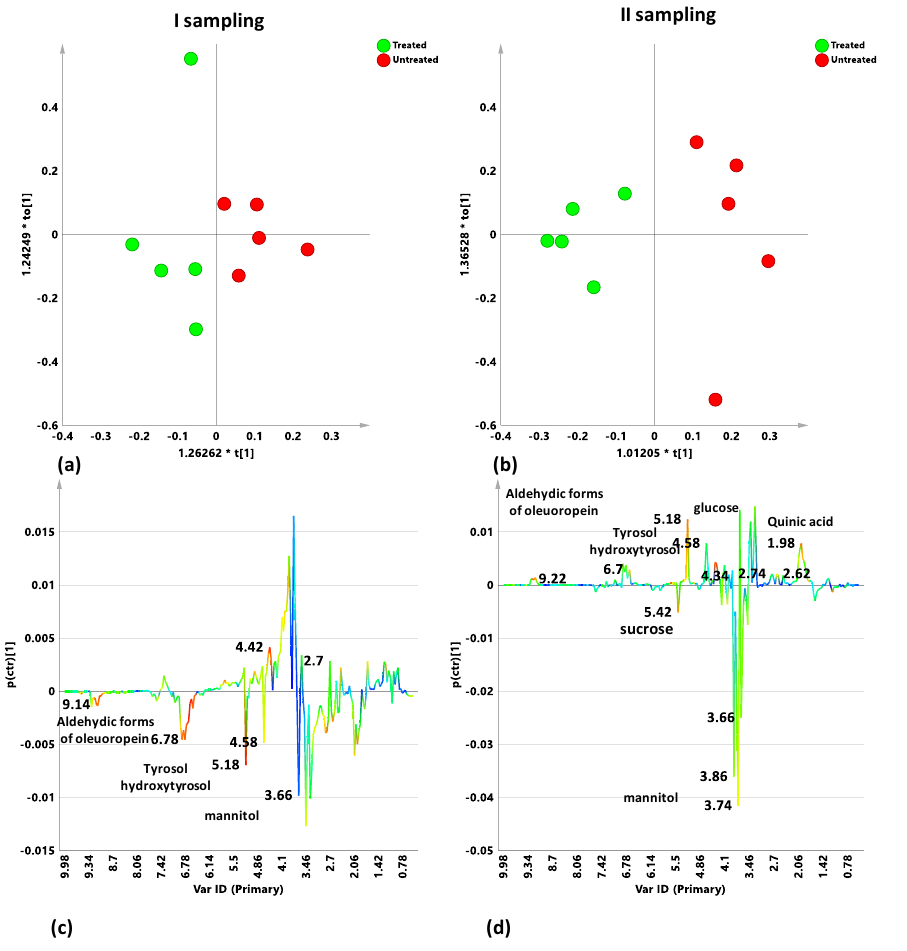
Figure 5. OPLS-DA t[1]/t[2] scores plot for infected control (red circles) and Dentamet ® -treated (green circles) Cellina di Nardò leaf samples from I ( a ) and II ( b ) samplings. S-line plots for the I ( c ) and II ( d ) sampling related models visualizes the p(ctr)[1] loading colored according to the absolute value of the correlation loading, p(corr)[1].